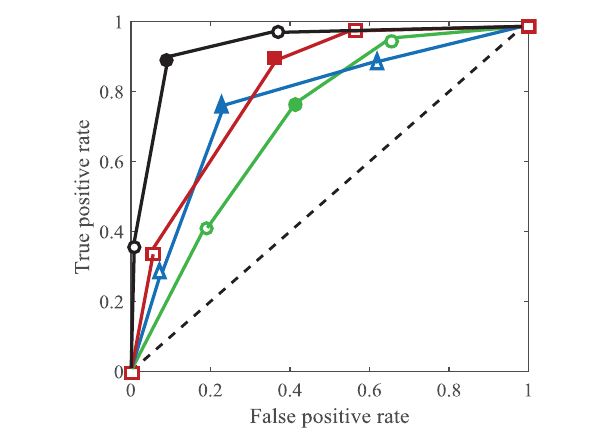
FIGURE 2 | Pictorial illustration of ROC analysis for assessing classifier performance. ROC curves for three hypothetical classifiers are plotted with their respective cutoff points in green, blue, and red. A combined ROC in black is plotted by selecting only three points over the 2 9 produced by the maximum likelihood method. For each curve, the solid marker identifies the operating point, and the empty markers label other cutoff